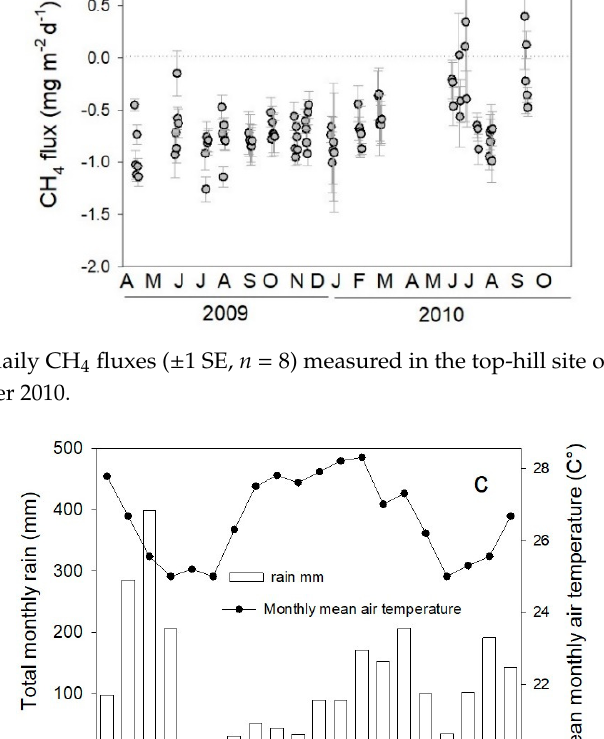
Figure 2. Total monthly rainfall (mm) and average mean monthly temperature estimated for the site from the TRMM database (Tropical Rainfall Measuring Mission, NASA).